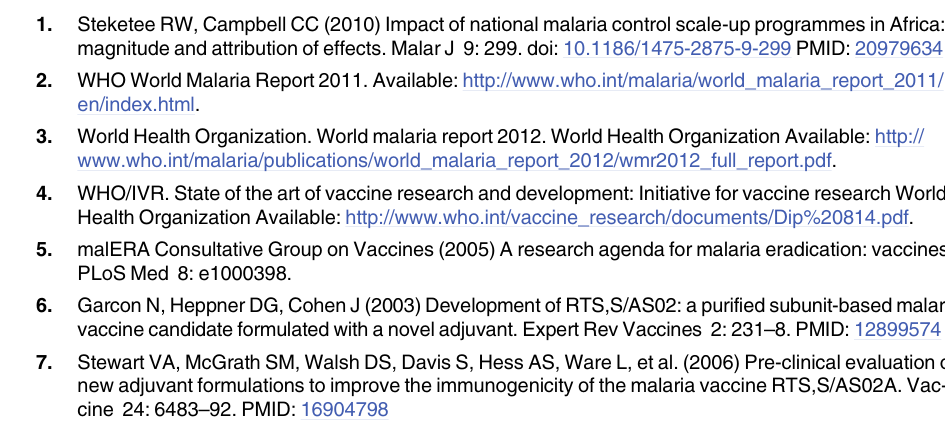
S3 Table. Logistic regression analysis modeling the probability of being